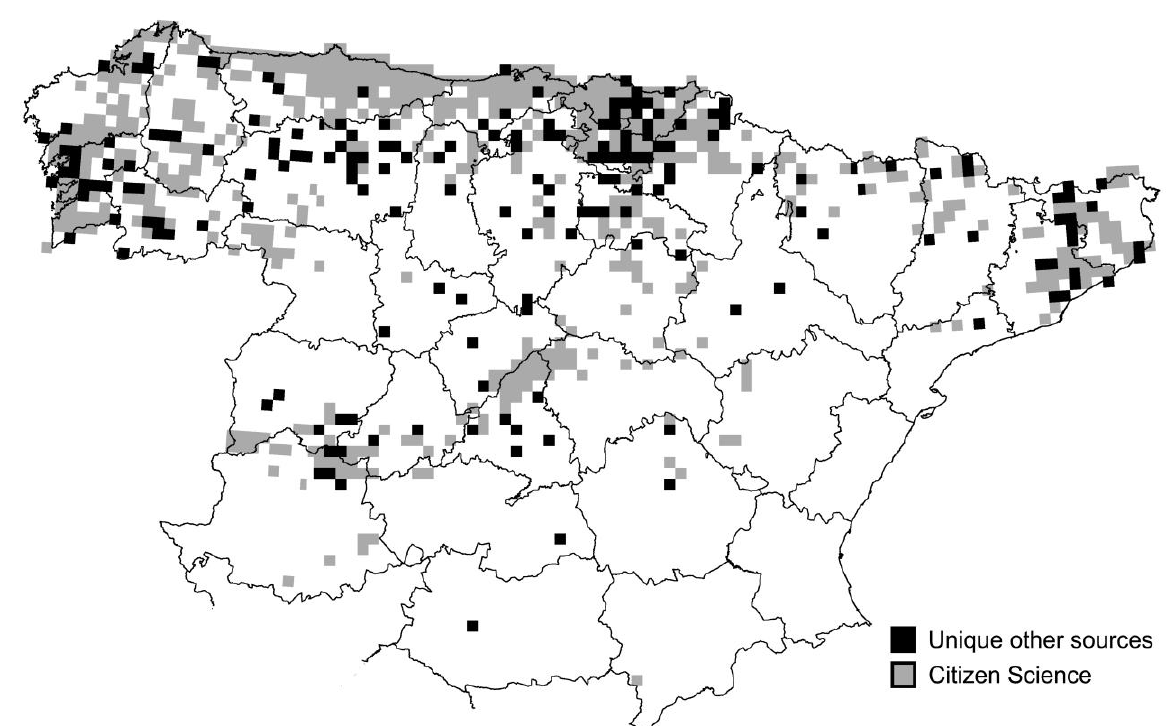
Figure 4. Distribution of the European stag beetle in Spain. Grey grid cells have been contributed by citizen science while black grid cells have been uniquely contributed by other data sources (publications or museum data).